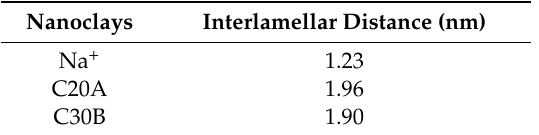
Table 3. Interlamellar distance of the as-received nanoclays.